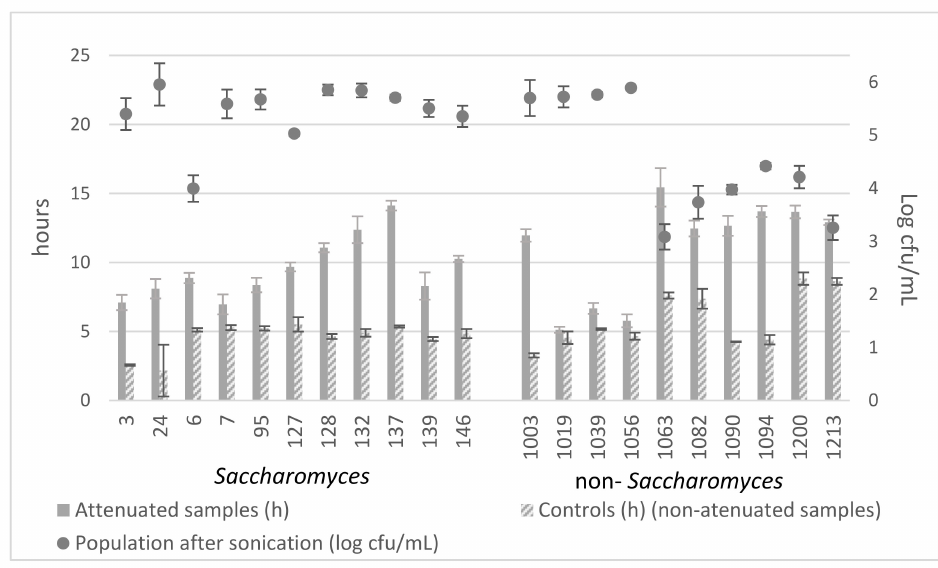
Figure 5. Yeast viability and vitality after the attenuation relative to the corresponding controls. Overall, without subjecting the strains to sonication, the strains of Saccharomyces had a similar vitality (they started growing between 2.17 h and 5.51 h), while for the non- Saccharomyces strains, there was more variation (between 3.27 h and 8.83 h). Comparing the final effect of attenuation on each strain ( α = 0.05, F = 69.22, Significance = 0.00), it was observed that the strain with the lowest vitality was 1063 (15.44 h) with significant differences, followed by the strains 137 (14.05 h), 1094 (13.70 h), and 1200 (13.67 h), among which there were no significant differences. Even without soni- cation, strains 1063 and 1200 already showed low vitality at 7.61 h and 8.83 h, respectively. Comparing the sonicated samples with their corresponding controls (samples not subjected to sonication), a greater attenuation effect was achieved in strains 137, 1003,